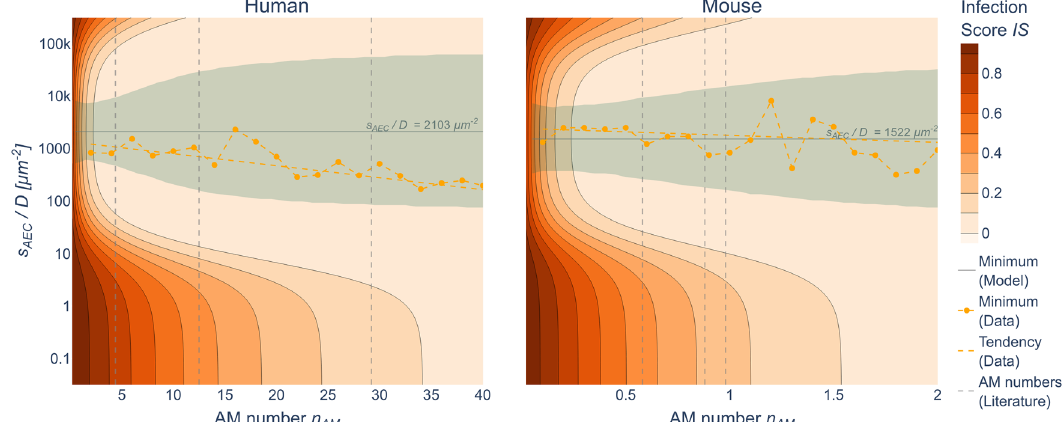
Fig. 6 SIM predictions of optimal chemokine ratios. Predicted infection scores (orange gradient) by the surrogate infection model (SIM) for pairs of AM numbers n AM and chemokine ratios s AEC = D for low fungal burden (see Supplementary Fig. 10 for high fungal burden) in the human (left) and murine (right) alveolus. Dashed vertical lines denote AM numbers from literature. The gray area represents the 95% con fi dence interval around optimal value s AEC = D for the lowest infection score derived from the SIM. Yellow points represent optimal values derived from the simulation data (yellow dashed lines as a guide for the eye).